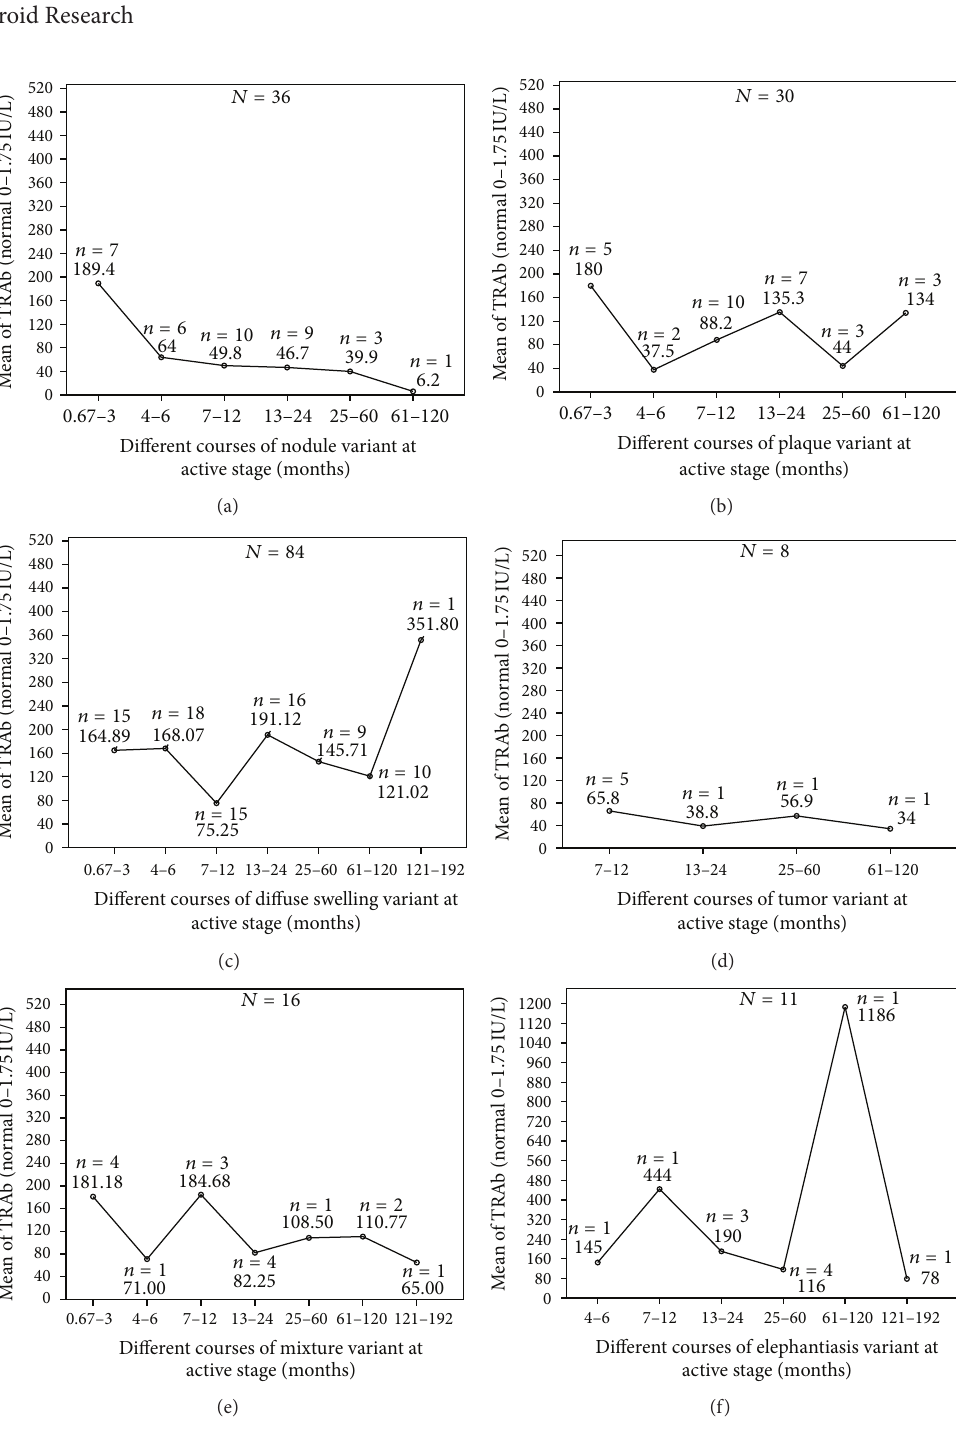
Figure 16: Trends of serum TRAb levels with the extension of courses at active stage in 6 PTM variants of 185 cases. (a) In nodule variant, means of serum TRAb titers at active stage invariably decreased from 189.4 IU/L at 0.67–3 months to 6.2 IU/L at 61–120 months in the course. (b) In plaque variant, means of serum TRAb titers at active stage went up-and-down with the extension of course. The lowest titers were 37.5 IU/L at 4–6 months and 44 IU/L at 25–60 months respectively and the highest titers were 180 IU/L at 0.67–3 months, 135.3 IU/L at 13–24 months and 134IU/L at 61–120 months respectively. There was no decreasing trend of autoimmune activity with the extension of course. (c) In diffuse swelling variant, means of serum TRAb titers at active stage went upward from 165IU/L at 0.67–3 months to 352 IU/L at 121–192 months with the extension of course. The trend of autoimmune activity fluctuated up with the extension of course. (d) In tumor variant, means of serum TRAb titers at active stage fluctuated with the extension of course. There was no difference of serum TRAb titers among 4 periods ( 𝐹 = 0.368 , 𝑝 = 0.781 ). (e) In mixture variant, means of serum TRAb titers at active stage fluctuated downward from 181.2IU/L at 0.67–3 months to 65IU/L at 121–192 months. (f) In elephantiasis variant, means of serum TRAb titers at active stage dramatically fluctuated with the extension of course ( 𝐹 = 36.228 , 𝑝 = 0.001 ). The lowest points were at 4–6 months, 25–60 months, and 121–192 months and the highest points were at 7–12 months and 61–120